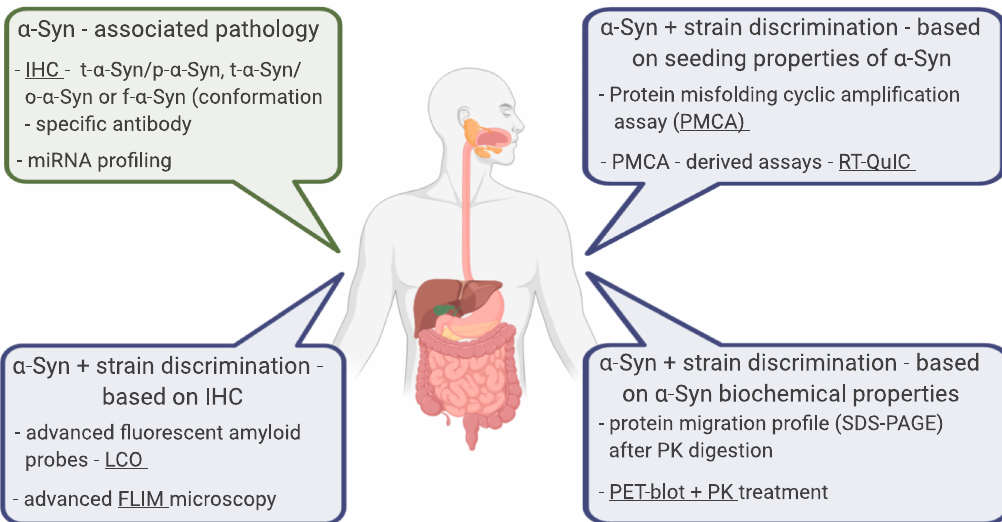
Figure 3. Alternative methods using gastrointestinal tract (GIT) tissues to detect α -Syn related pathogenesis and its strains discrimination. We propose a conventional immunohistochemical analysis (IHC) focused on the detection of pathological forms or the ratio between t- α -Syn and these forms instead of the detection of t- α -Syn. Similarly, miRNA profiling targeting specific disease-modulating miRNAs might be a relatively rapid tool for the detection of the early stages of the disease in GIT tissues (green boxes). Because different α -Syn strains are responsible for the diversity of clinical manifestations of neurodegenerative diseases, we propose several methods to distinguish these strains based on their specific physical and biochemical properties (blue boxes).